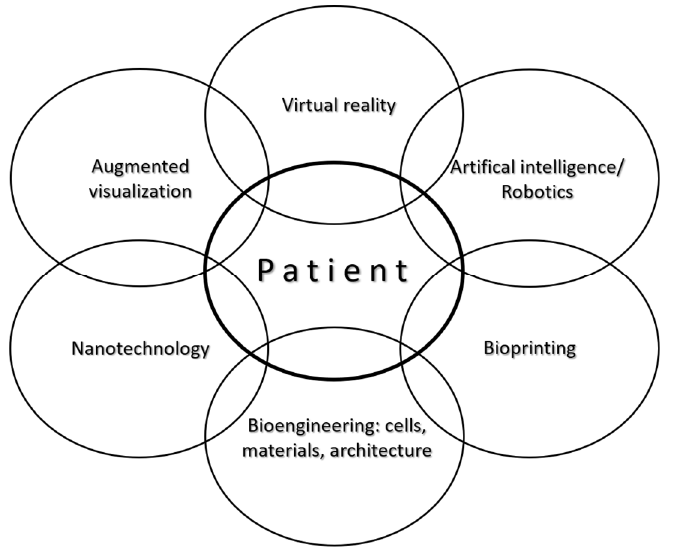
Figure 8. New methods and applications centered around the patient will revolutionize regenera- tive surgery.